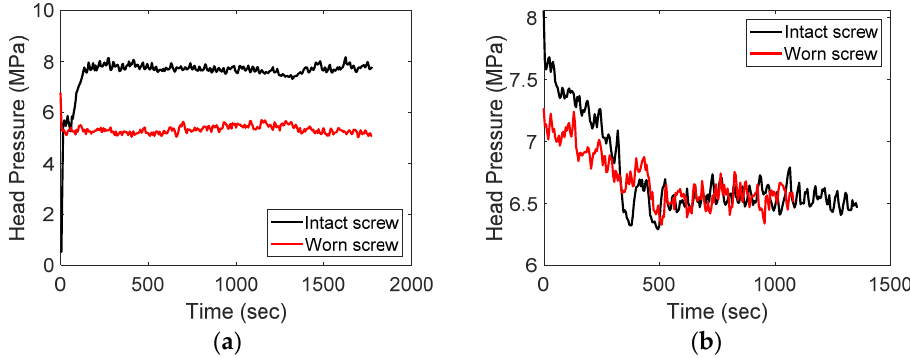
Figure 7. Head pressure change according to screw wear: ( a ) no catheter production; ( b ) during catheter production.